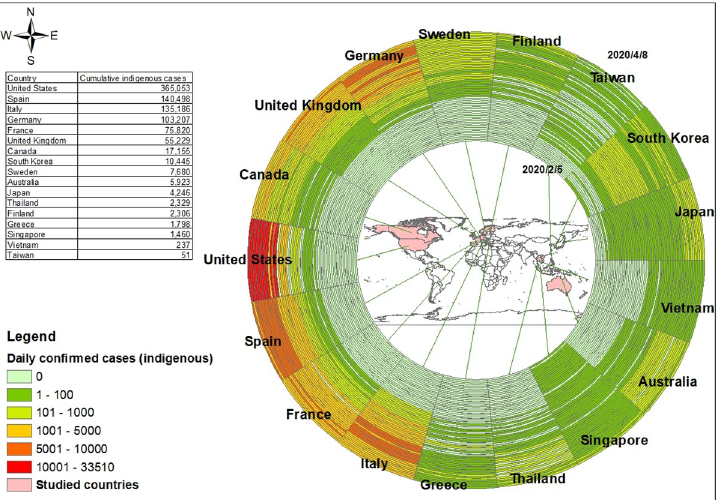
Fig 1. Ring map of daily confirmed local transmission cases of COVID-19, Feb. 5 to Apr. 8, 2020.